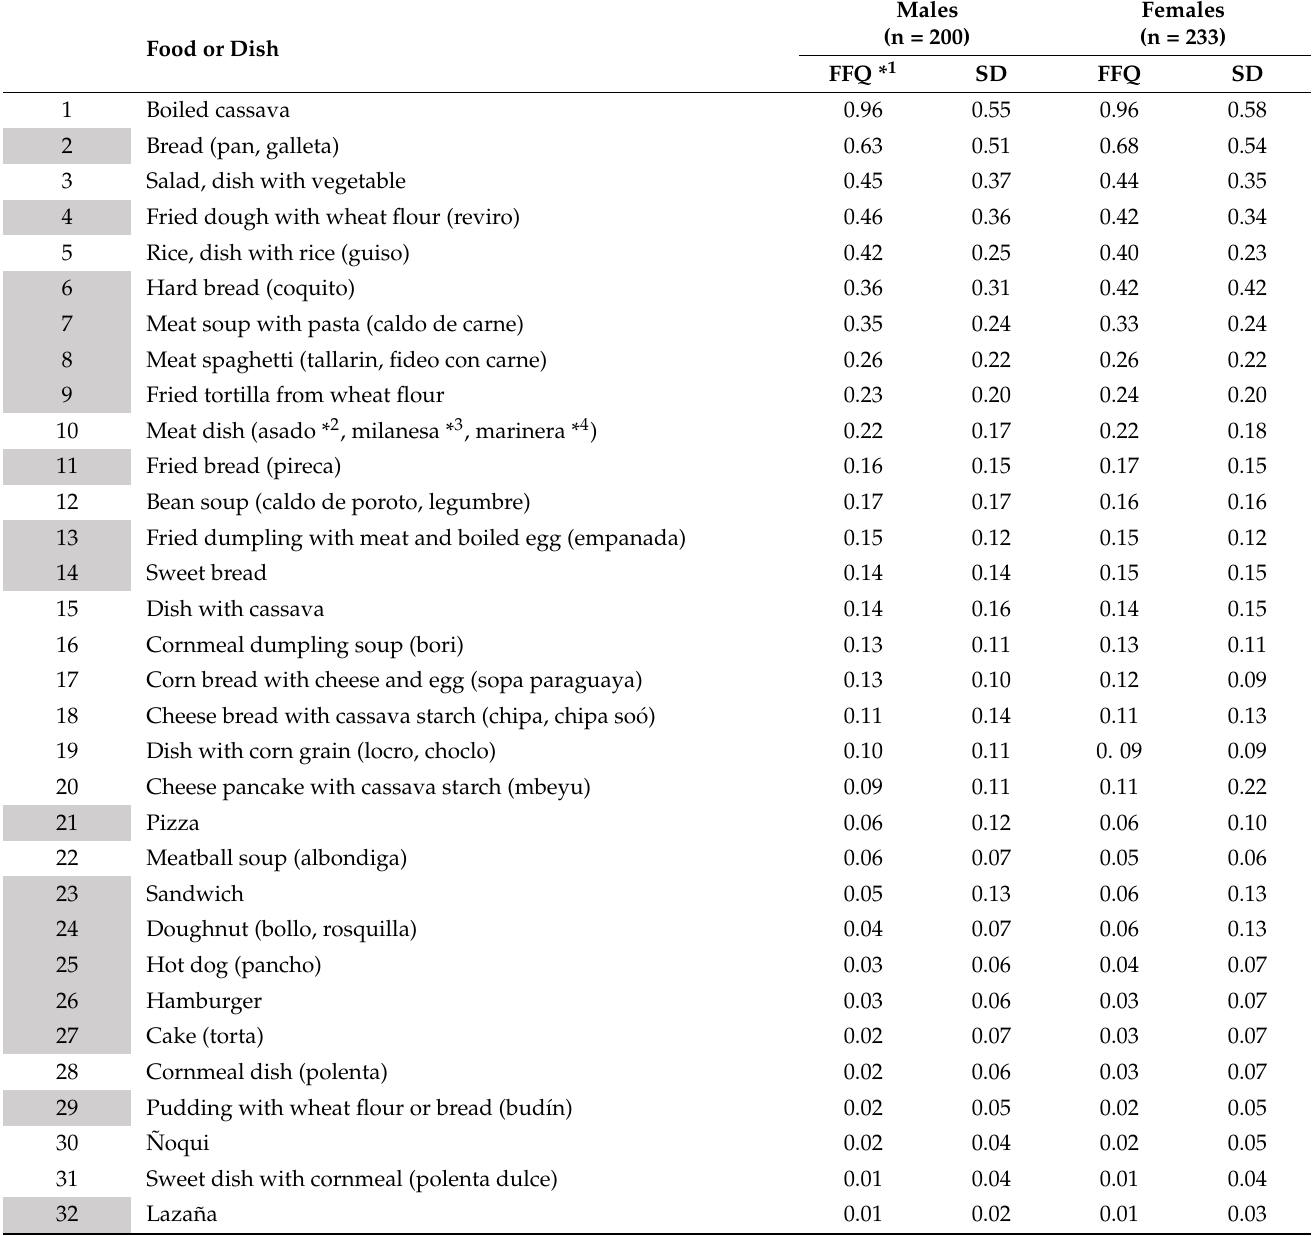
Table 2. FFQ values of food and